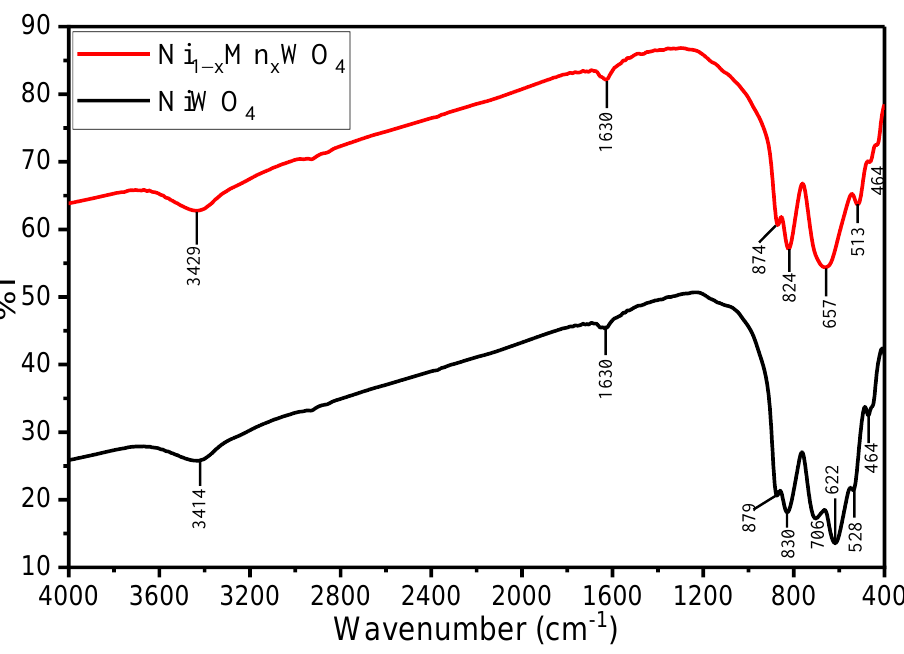
Figure 2. FTIR spectra of NiWO 4 (black line) and Ni 1 − x Mn x WO 4 NC (red line) calcined at 600 °C .